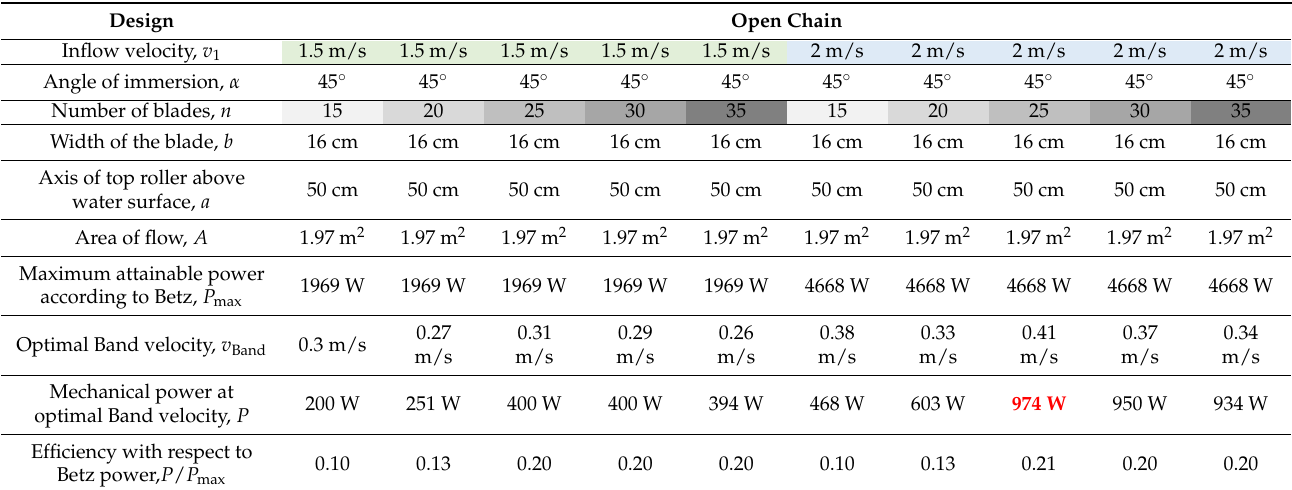
Figure 10. Side view of the pressure profile. Table 2. Result summary I for Open-Chain ECB (red color is one of the optimum variants which is mentioned later in the